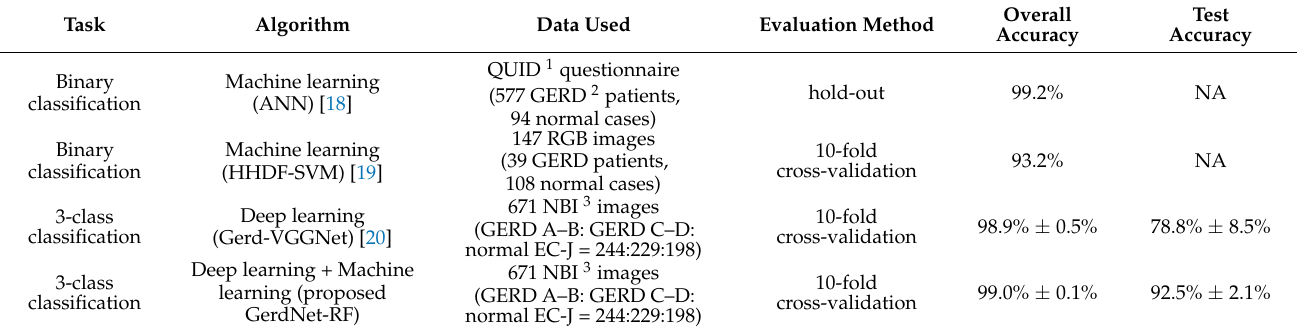
Table 5. Performance comparison of different AI systems for classification of GERD.